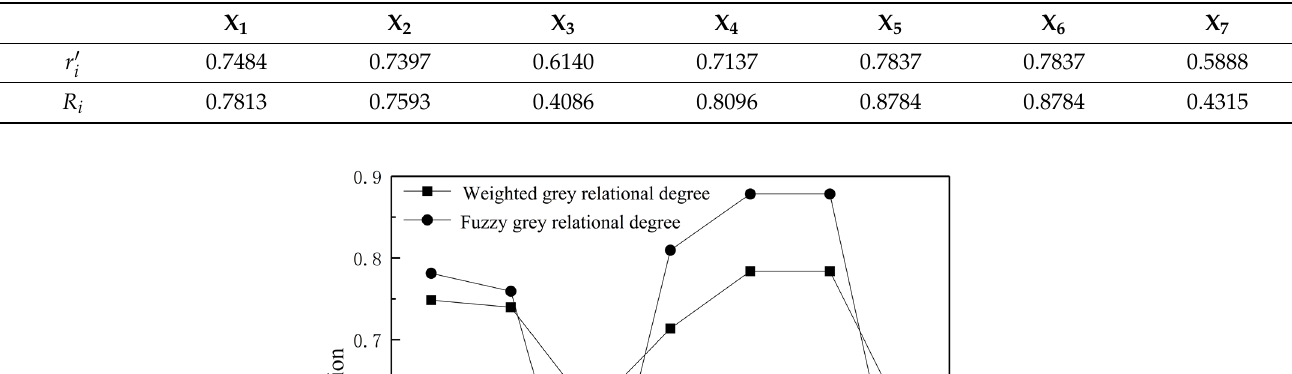
Table 5. Weighted grey relational degree and fuzzy grey relational degree of the influencing factors.